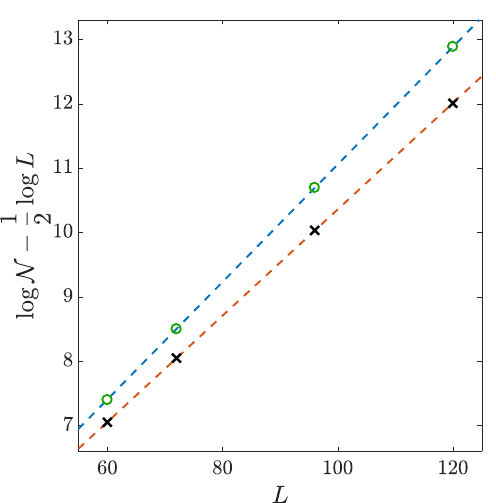
Figure 13: Logarithm of the Gaudin norm, shown for the one-cut solution with n = 1, ν = 1 . Green circles (black crosses) show numerical results for δ = 0 ( δ = 1). Linear 3 fits are indicated by dashed lines.